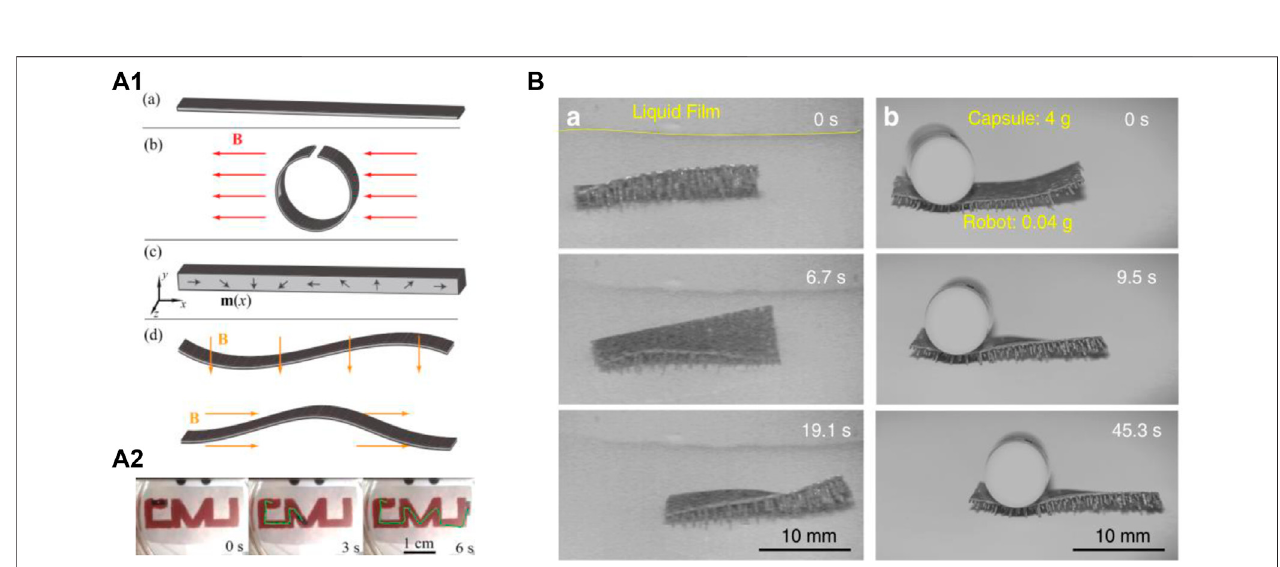
FIGURE 5 | (A) Schematic illustration of shape of bilayer at different temperature conditions. Reproduced from Jiang et al. (2015) with permission of WILEY-VCH. (B) Reversible bending behavior of thermo-responsive hydrogel actuators. Reproduced from Mo et al. (2020) with permission of Royal Society of Chemistry.